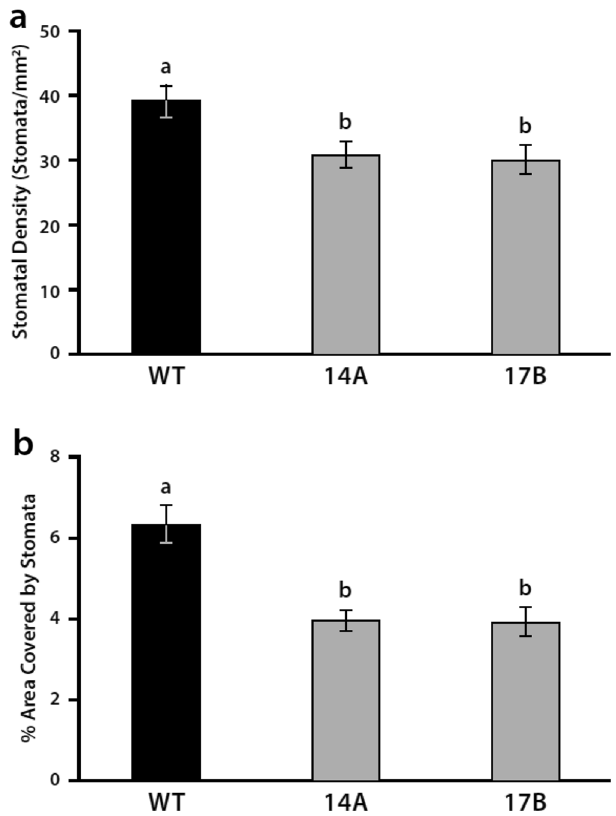
Figure 9. Leaves from 14A and 17B transgenic soybean lines display a significant decrease in stomatal density and stomatal coverage compared to wild-type (WT). Analysis of stomata of WT, 14A and 17B leaves shows ( a ) lower stomatal density for 14A and 17B leaves ( p < 0.05), and ( b ) smaller percent area covered by stomata for 14A and 17B leaves compared to WT ( p < 0.001). Data represent means ± SE, with statistical differences based on the Student’s t